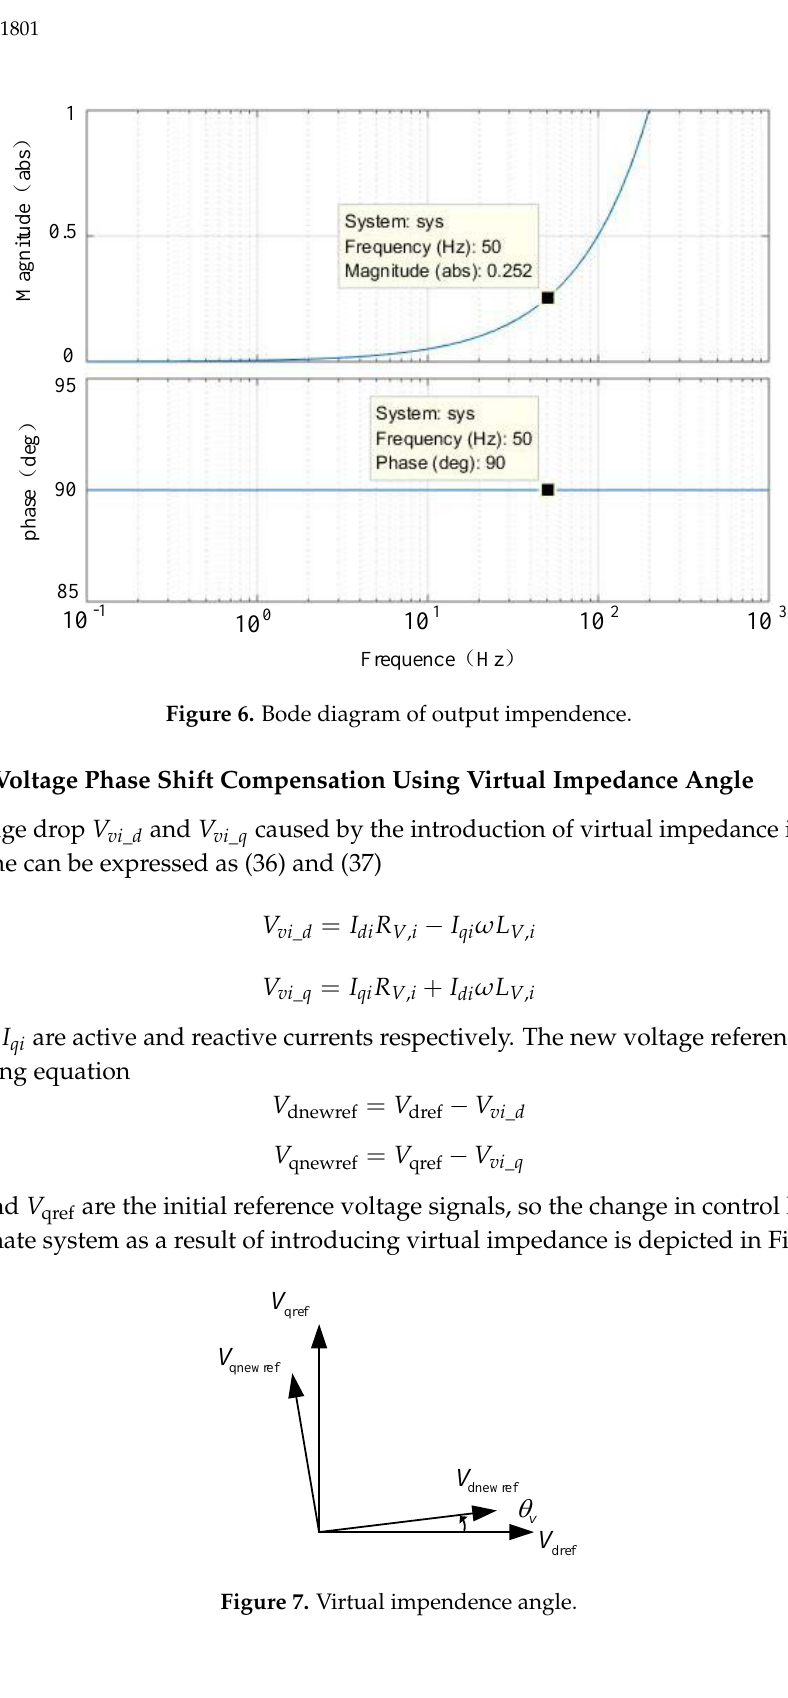
Table 2. Parameters of the droop control.